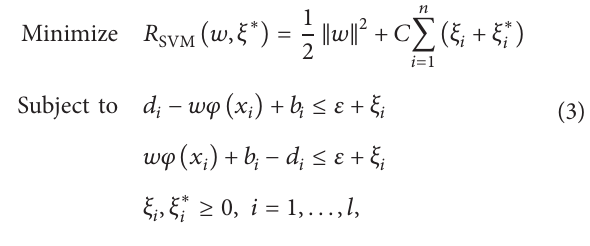
Figure 2: The network architecture of